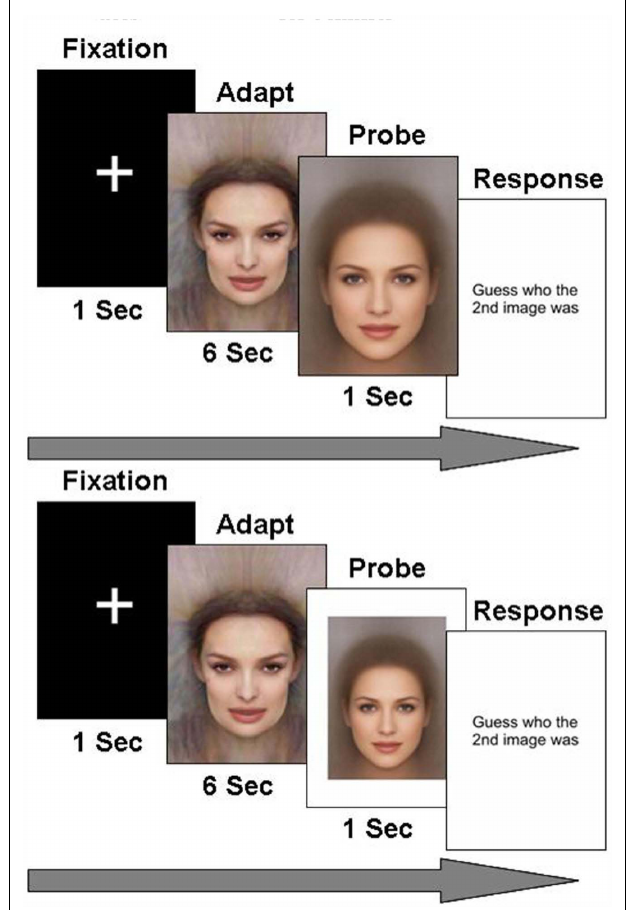
FIGURE 2 |Trial structure for full-size images (top) and 70% size images (bottom) as probe faces. The antiface for Jennifer Aniston is used